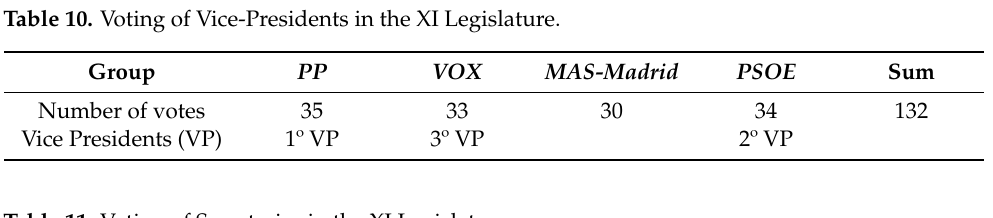
Table 11. Voting of Secretaries in the XI